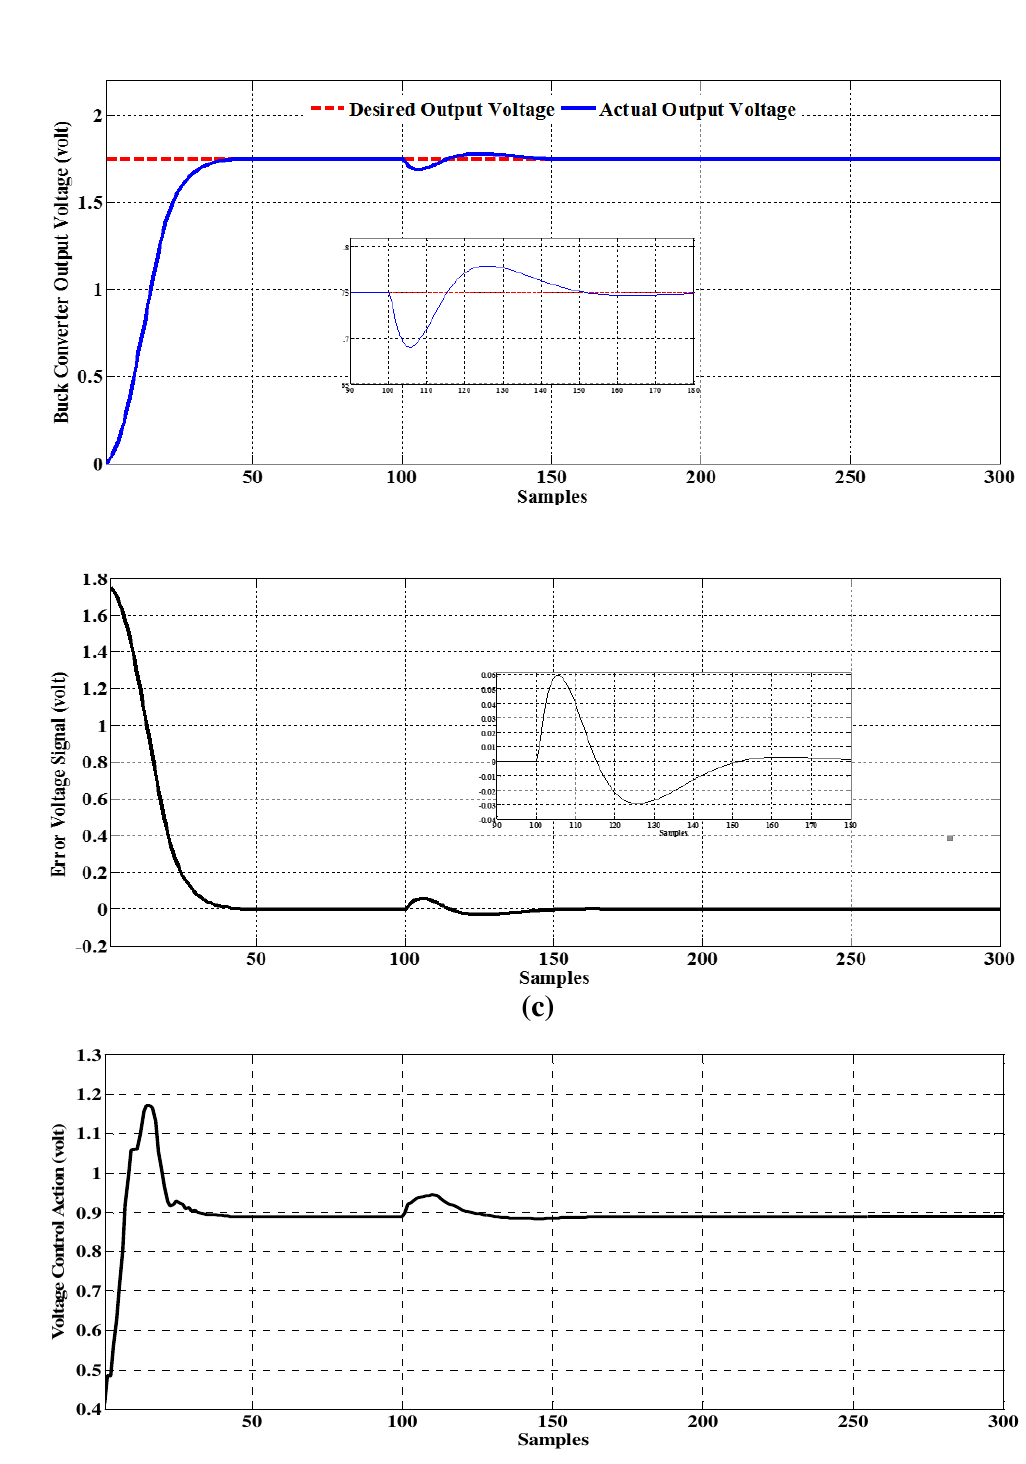
Fig. 10. Simulation results of the MENN-PID controller with disturbance effect: (a) Output voltage for Buck converter model; (b) Voltage error; (c) Voltage control action